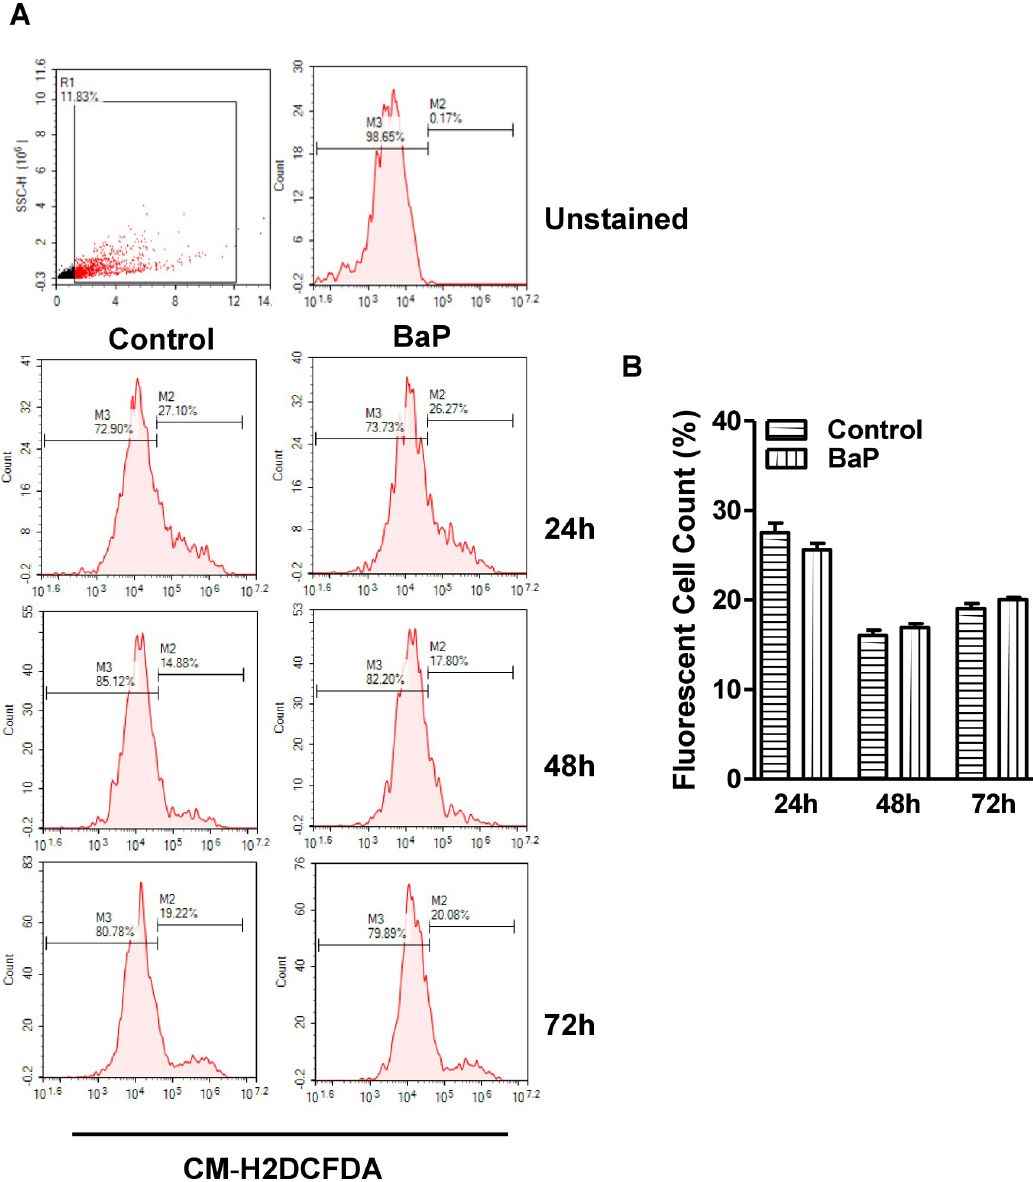
Fig 6. Effect of BaP on ROS in SVG cells (A, B). (A) The SVG cells were treated with 1 μ M BaP for 24, 48, and 72 h. ROS level using flow cytometry. (B) Data is quantified using florescent cell count that were measured in %. Statistical analyses were carried out by using Student’s t-test (two groups each time point). Results are expressed as means ± S.E.M of n = 3